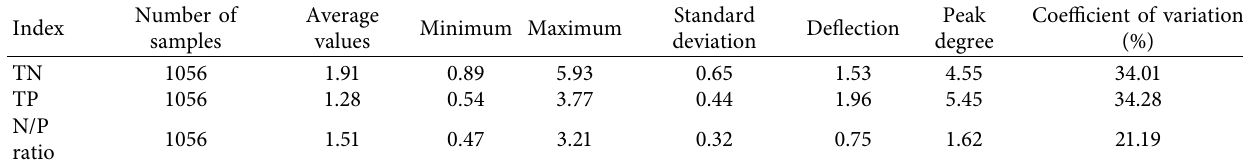
Table 1: Descriptive statistical characteristics of soil TN, TP content, and N/P.